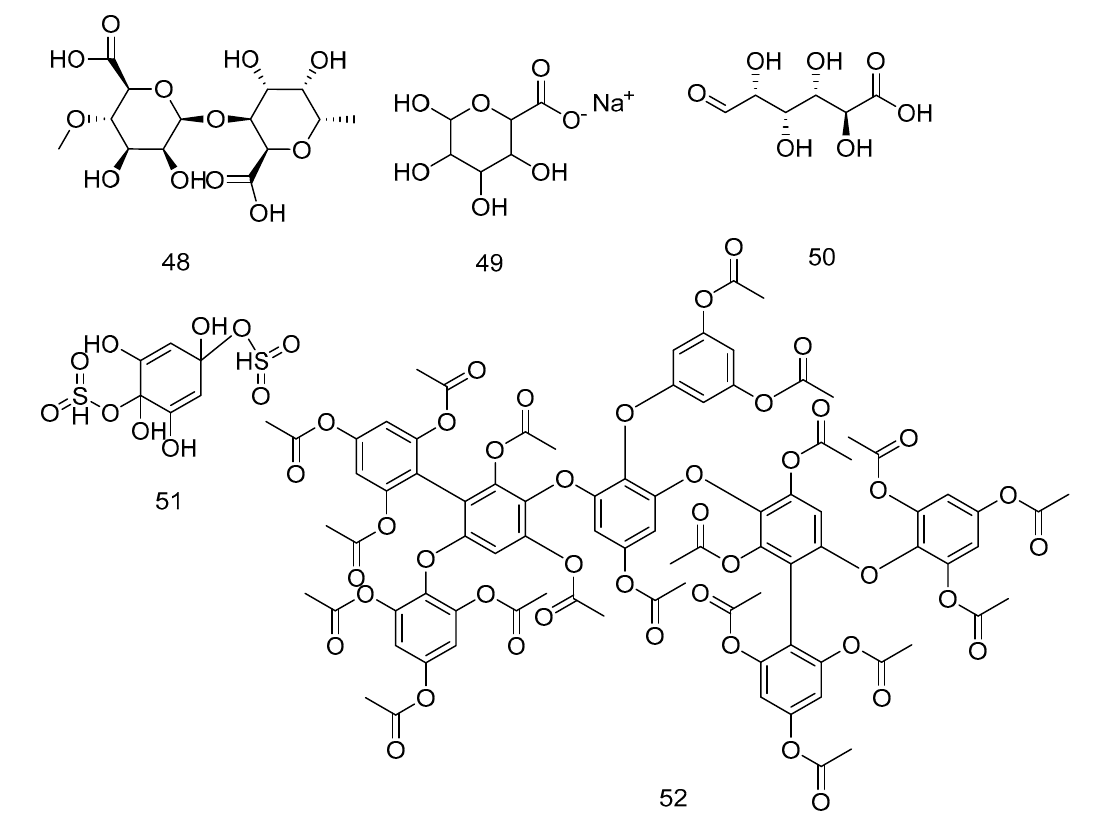
Figure 12. Compounds from 48 – 52 (Acids, sugars, and esters).